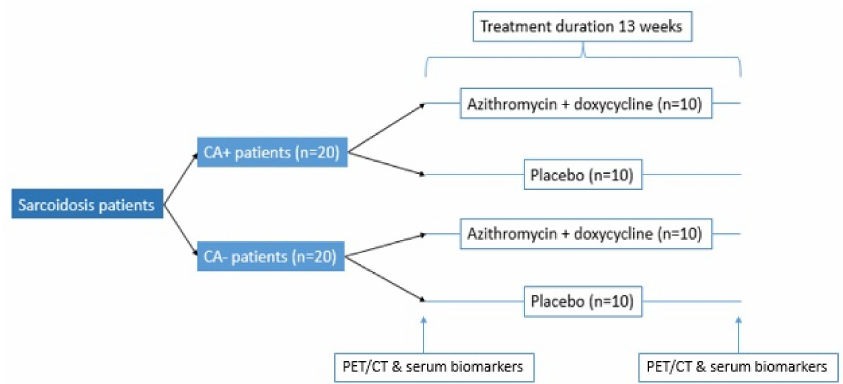
Figure 4. Flow chart of the PHENOSAR trial. Patients are stratified based on the presence or absence of Cutibacterium acnes in their granulomas. After this stratification, patients are randomized to receive either 500 mg Azithromycin 3 times a week and daily doxycycline, or a placebo for 13 weeks. CA+ = sarcoidosis patients with the presence of C. acnes in granulomatous tissue. CA − = sarcoidosis patients with no C. acnes in their granulomatous tissue. PET/CT = Positive Electron Tomogra- phy/Computer